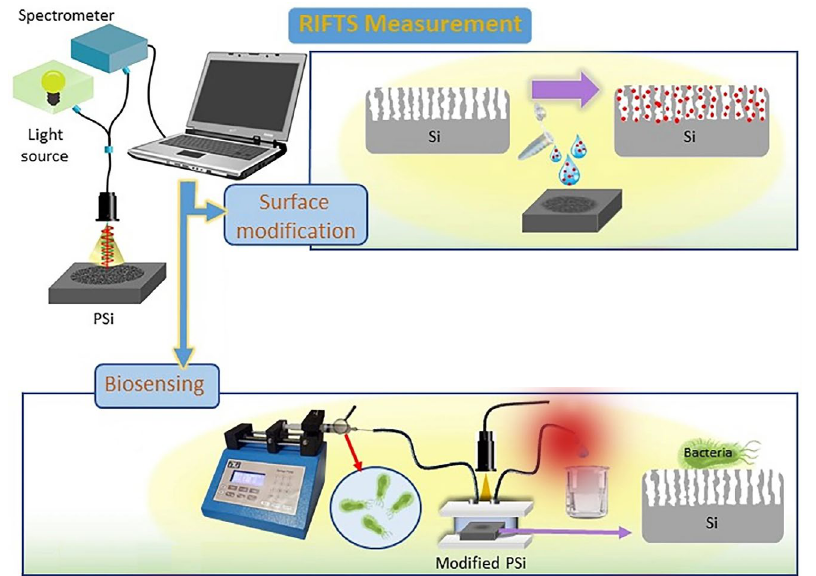
Figure 1. Schematic representation of a reflective interferometric Fourier transform spectroscopy (RIFTS) set up. During surface modification, analyte molecules enter the Si pores. Biosensing monitoring of a bacterial suspension is carried out in a fluidic system. Reproduced from